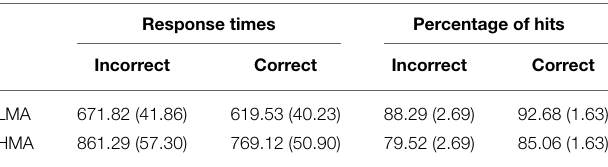
TABLE 1 | Means of response times (in ms) and of percentage of hits (standard error of the mean in brackets) for correct and incorrect proposed solutions for the LMA and HMA